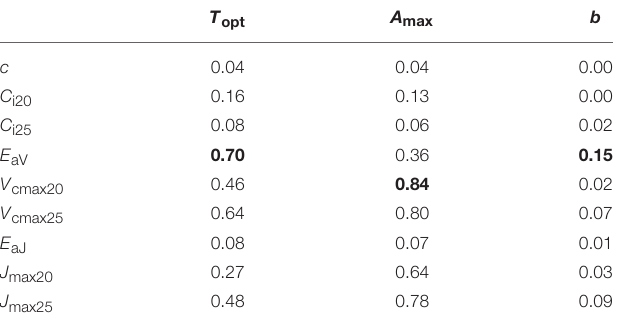
TABLE 4 | Determination coefficient ( r 2 ) of regression for parameters of temperature dependence of photosynthesis on biochemical parameters.